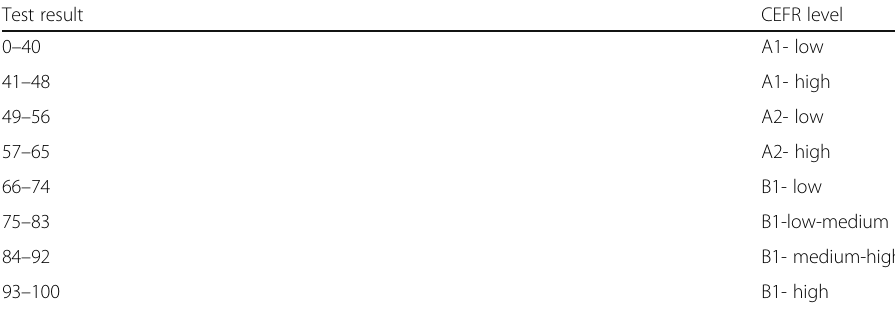
Table 1 Band score of CEFR Headway placement